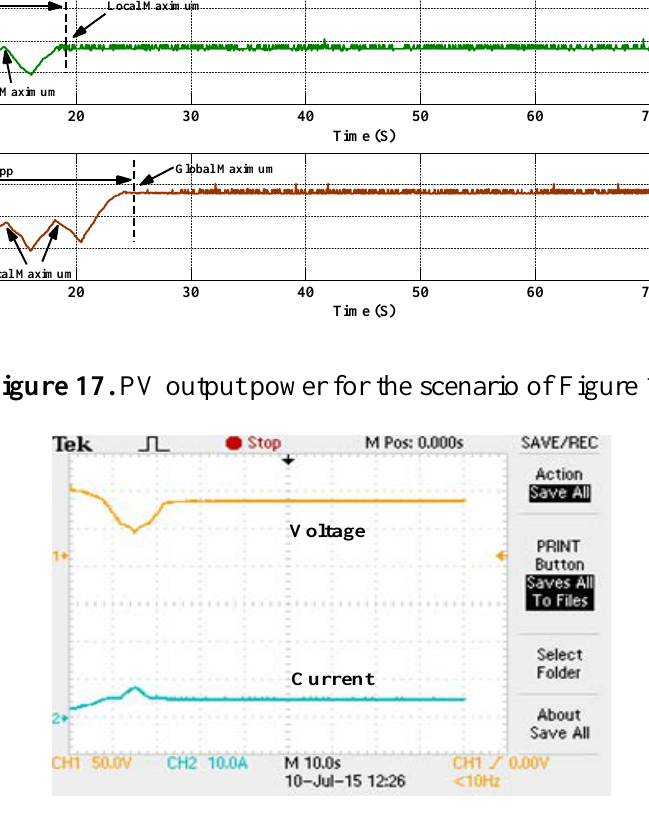
Figure 18. The performance of voltage and current for the scenarios of Figure 16 by implementing DSMPP